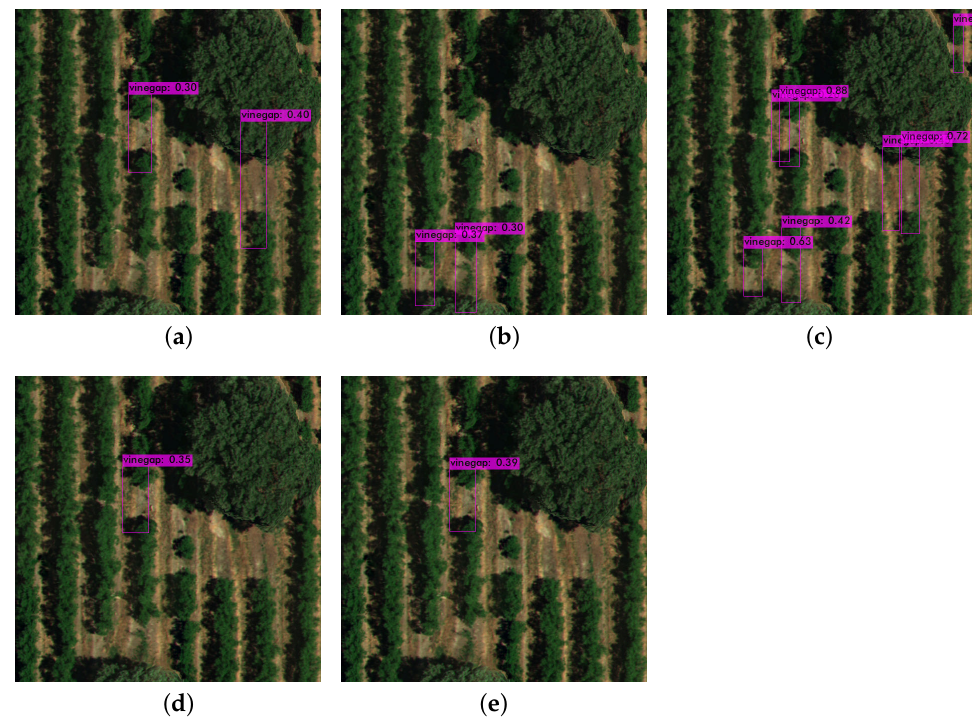
Figure 4. Examples of regression-based networks’ results with predicted boxes from the respective networks, and confidence values for each object identified. Dataset: RGB; ( a ): Tiny-YOLO; ( b ): YOLO; ( c ): Tiny-YOLOv2; ( d ): Tiny-YOLOv3; ( e ):